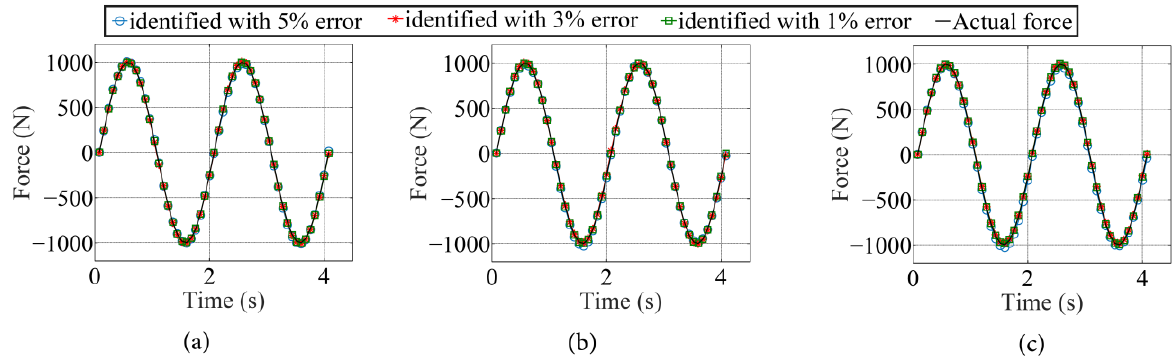
Figure 15. The identified load with two sensors and ( a ) no regularization, ( b ) γ = 10 − 22 , and ( c ) γ = 10 − 18 .